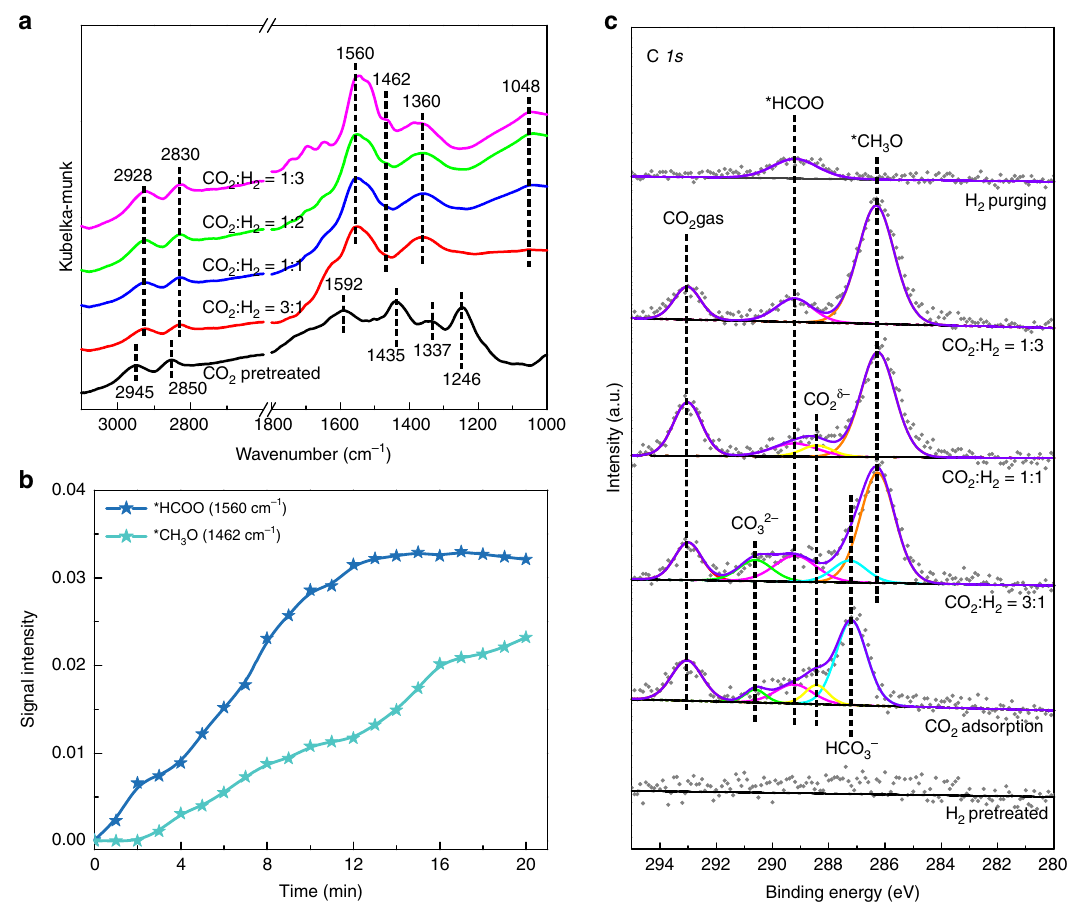
Fig. 4 Mechanism of CO 2 hydrogenation on Co@Si 0.95 catalyst. a In situ DRIFTS spectra of Co@Si 0.95 catalyst at 350 °C in contact with CO 2 + H 2 . b Time-dependent DRIFTS band intensities characterizing surface *HCOO and *CH 3 O species during the CO 2 + H 2 reaction on Co@Si 0.95 at 350 °C. c In situ C 1s XPS spectra of Co@Si 0.95 in contact with 1.2 mbar of CO 2 + H 2 atmosphere with controlled ratios at 250